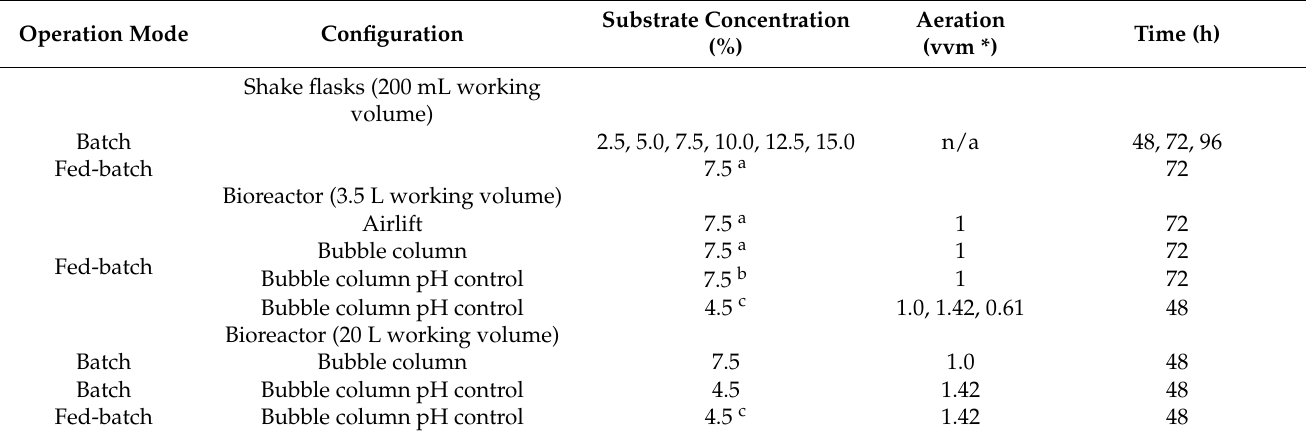
Table 1. Summary of the cultivation